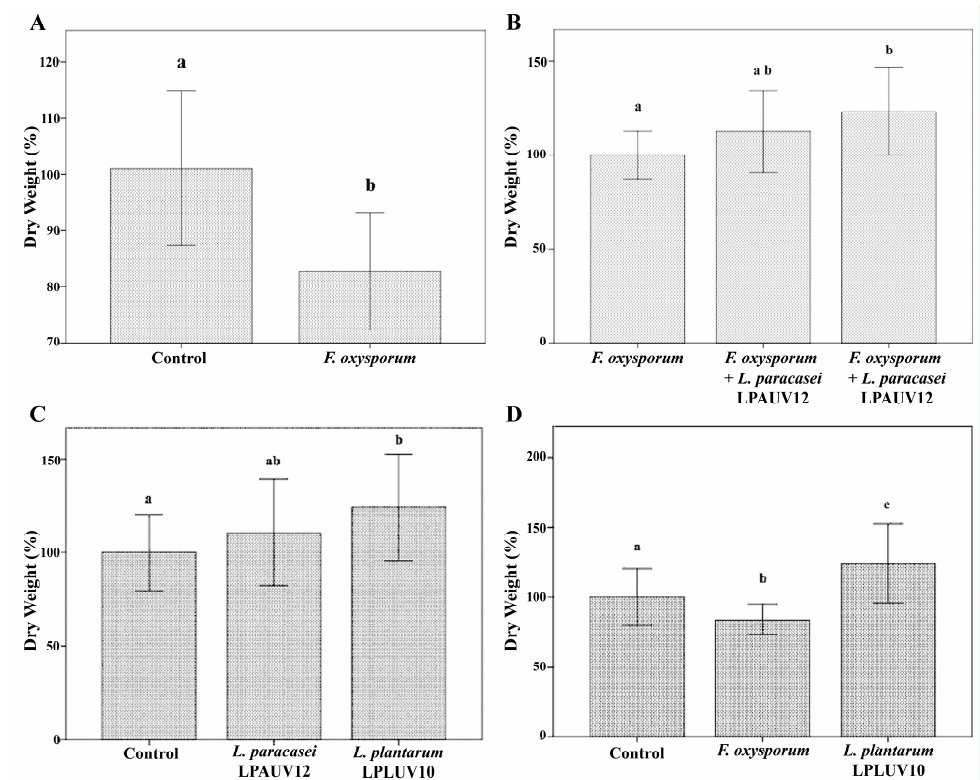
Figure 3. Ability of selected malolactic strains to act as biocontrol and biofertilizer agents. ( A ): Effect of F. oxysporum on L. esculentum plants. ( B ): Effect of the treatment with selected LAB strains on the infection of L. esculentum plants by F. oxysporum . ( C ): Effect of the treatment with selected LAB strains on the growth of L. esculentum plants. ( D ): Effect of the treatment with strain LPLUV10 on the growth of L. esculentum plants in comparison with plants infected with F. oxysporum . Values are mean ± SD. Different letters indicate significant differences ( p ≤ 0.05).